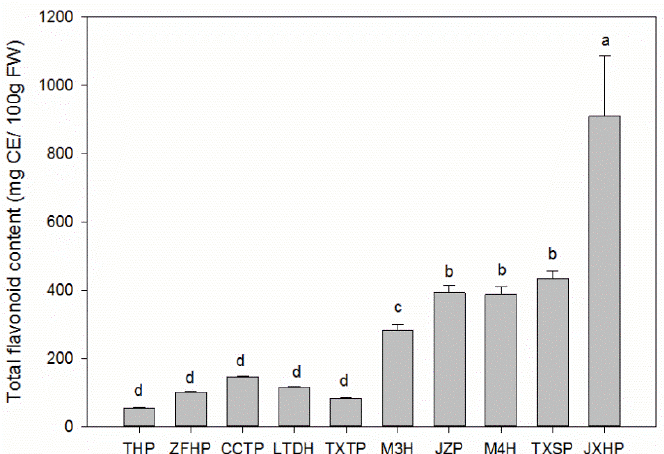
Figure 3. Total flavonoid contents of five sweet and five sour wampee varieties. Bars with no letters in common are significantly different ( p < 0.05).